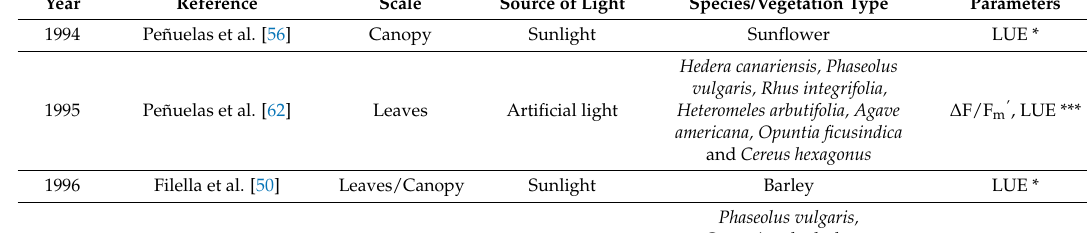
Table 1. List of works, which were analyzed in the meta-analysis, and details of measurement of photochemical reflectance index (PRI) and photosynthetic parameters in each work. LUE = light use efficiency; ∆ F/F m ’ = quantum yield of photosystem II; NPQ = nonphotochemical quenching of chlorophyll